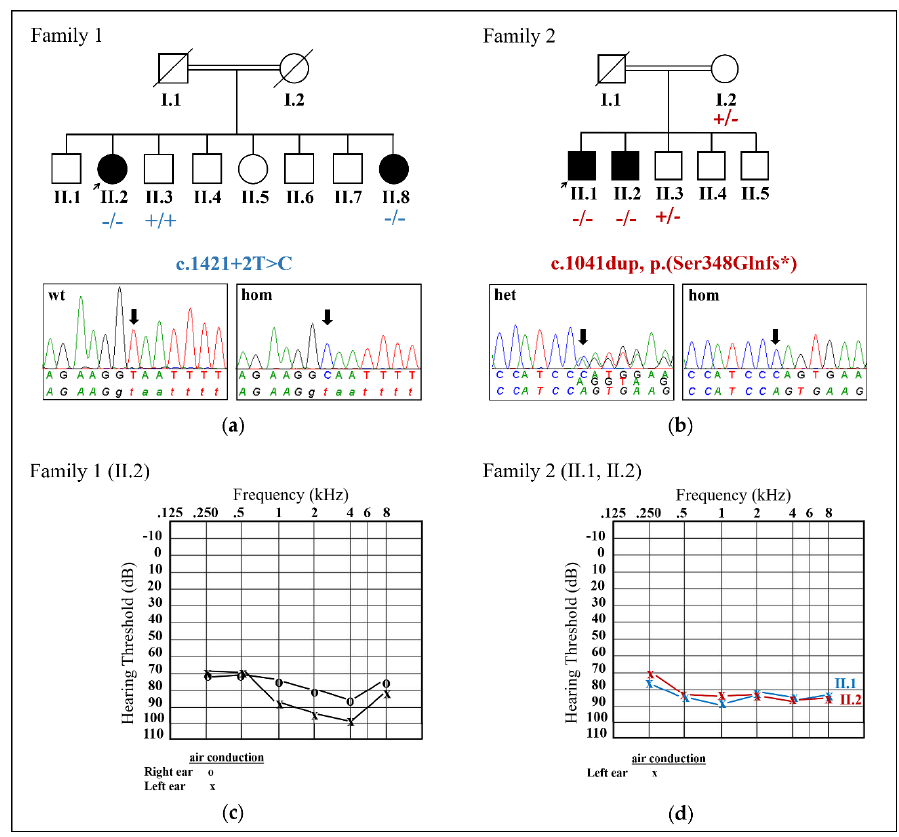
Figure 1. Pedigree, segregation of the CDC14A variants in families 1 and 2 and pure-tone audiometry. ( a , b ) An Iranian (( a ) family 1) and Pakistani family (( b ) family 2) with a consanguineous background, each showing two affected individuals (( a ), II.2, II.8; ( b ) II.1, II.2) who are shown in black symbols. Unaffected parents and siblings are shown in white symbols. The probands are marked with arrows. The mutated allele is marked with a “-”. The wild type allele is displayed with a “+”. Sanger sequence chromatograms of the CDC14A c.1421+2T>C variant in wild type (WT; ( a ), left) and homozygous (( a ), right) orientation and the CDC14A c.1041dup variant in heterozygous (( b ), left) and homozygous (( b ), right) orientation. ( c , d ) Audiograms showing pure-tone air conduction thresholds of II.2 (( c ), family 1) and II.1, II.2 (( d ), family 2). Air conduction thresholds for right and left ears are represented with circles and crosses, respectively. Abbreviations: het, heterozygous; hom, homozygous; wt, wild type.